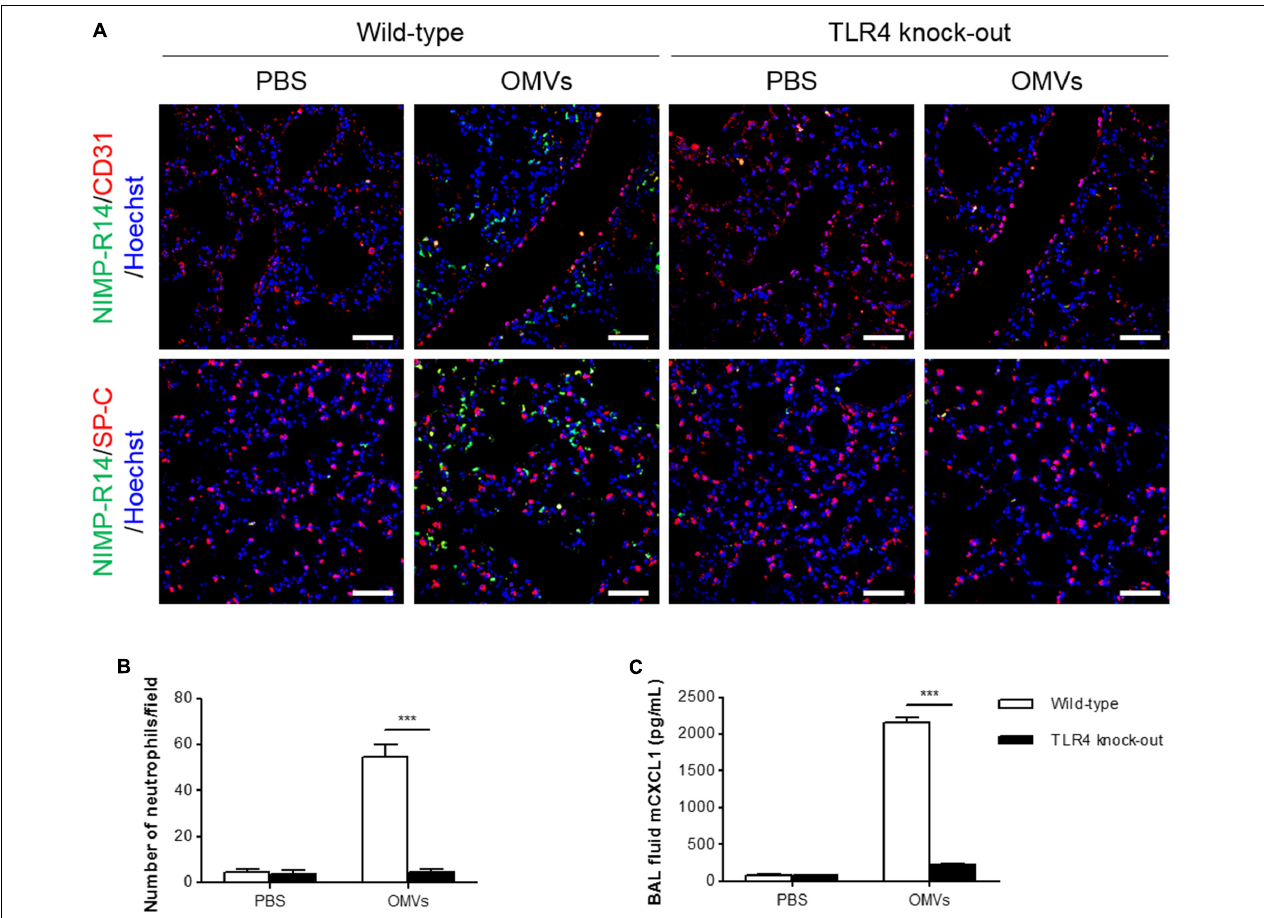
FIGURE 5 | Suppression of OMV-induced neutrophil transmigration in murine lungs of TLR4 knockout mice. Wild-type and TLR4 knockout mice were intraperitoneally administered with PBS or E. coli OMVs (15 µ g in total protein amount) for 6 h. Five animals were used in each group. (A,B) The lung sections of five mice at 6 h after E. coli OMV introduction were immunostained with anti-NIMP-R14 (green; neutrophils) and anti-CD31 (red; endothelial cells) or anti-SP-C (red; lung epithelial cells) antibodies, and counterstained with Hoechst 33258 (blue; nuclei). Representative fluorescence images are shown here. Scale bars = 50 µ m. The number of neutrophils per field was counted from five confocal microscopy images obtained from the lung sections of five mice (B) . (C) The concentration of CXCL1 was measured in the BAL fluid by ELISA ( n = 5). Data were represented as mean ± SEM. ∗∗∗ P < 0.001, calculated by two-way ANOVA with Bonferroni correction for multiple